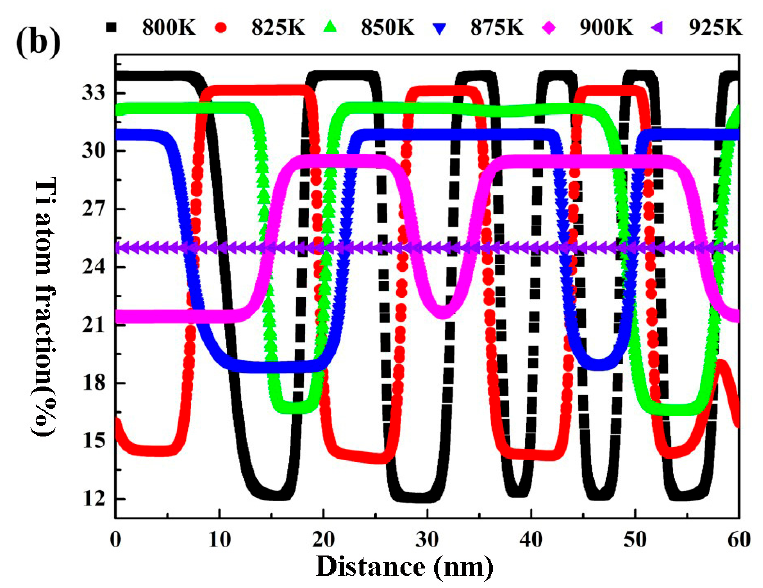
Figure 7. The Ti and Zr concentration fl uctuation curves along the horizontal direction of the Zr- 40Nb-25Ti alloy aged at di ff erent temperatures for 1000 min. ( a ) Zr concentration and ( b ) Ti concen-